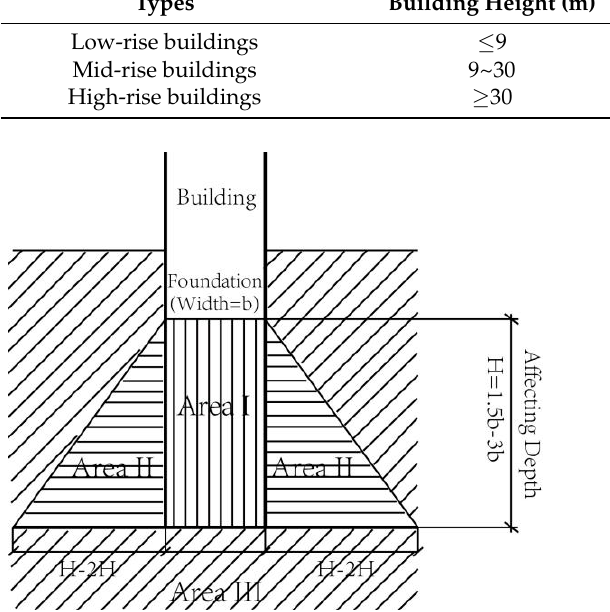
Figure 10. Zoning diagram of building foundation influence.